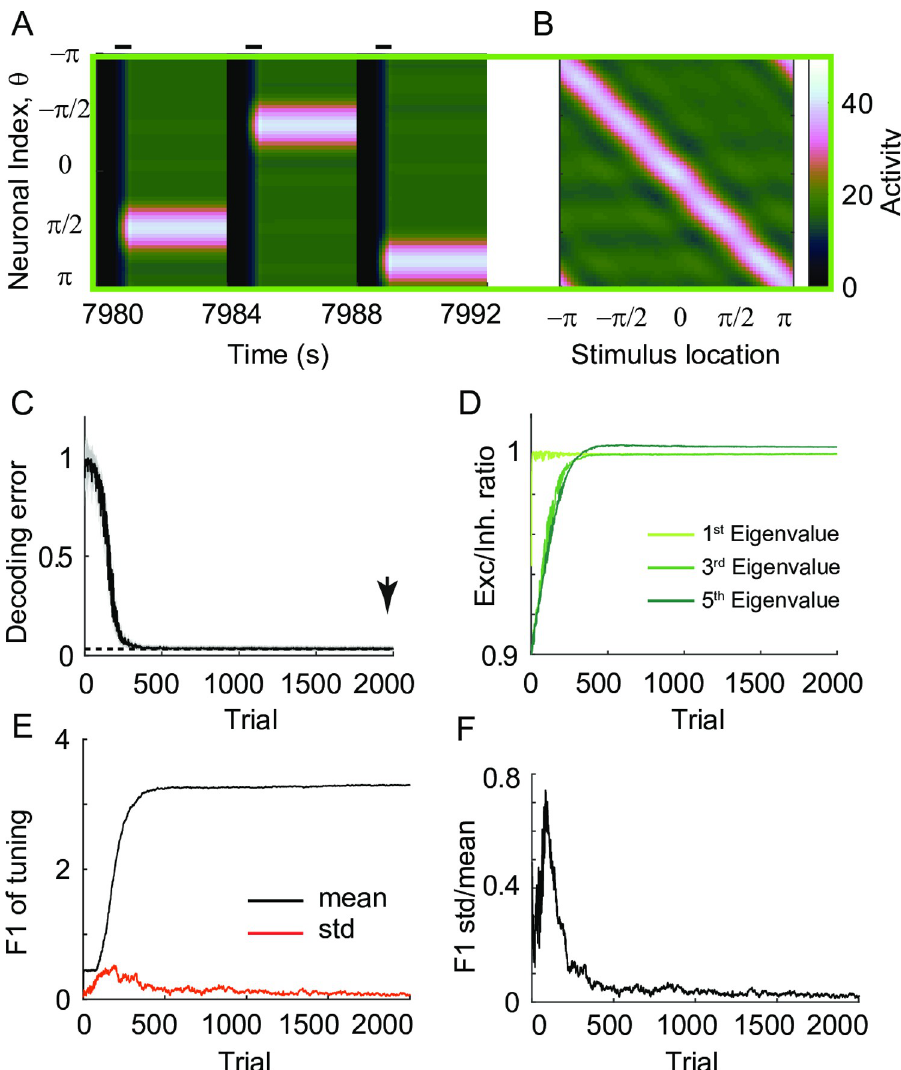
Fig 6. The effect of differential plasticity under small global perturbation. A: Recovery of location-coded memory under differential plasticity with learning rate α = 10 − 3 and 10% global perturbation in the E-to-E connections. B: d Activity pattern at the end of the delay period after the recovery. With the connectivity frozen at trial 2000 (arrow in C), the spatial pattern of activity at the end of the delay period was shown for different stimulus locations. C: Decrease of decoding error with learning. An individual trial refers to one memory task with a specific stimulus location. For each trial, we took the snapshot of activity at the end of the delay period as in B and quantified the mean of the decoding error using the population vector decoder (black curve; Methods) and the standard error of the mean (grey shaded area). Dashed line indicates decoding error before perturbation. D: Recovery of E-I balance for different Fourier modes. The eigenvector decomposition reveals the effective time constant of decay and recovery of E-I balance in different Fourier modes (S2 Fig; Methods). E: Mean (black) and standard deviation (red) of spatial selectivity across neurons quantified by the first Fourier component of each neuron’s tuning curve at the end of the delay period. F: Normalized standard deviation of spatial selectivity in (E), where its decrease with learning indicates recovery of